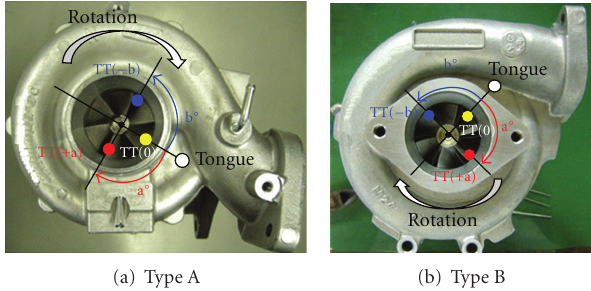
Figure 4: Definition for position of injection